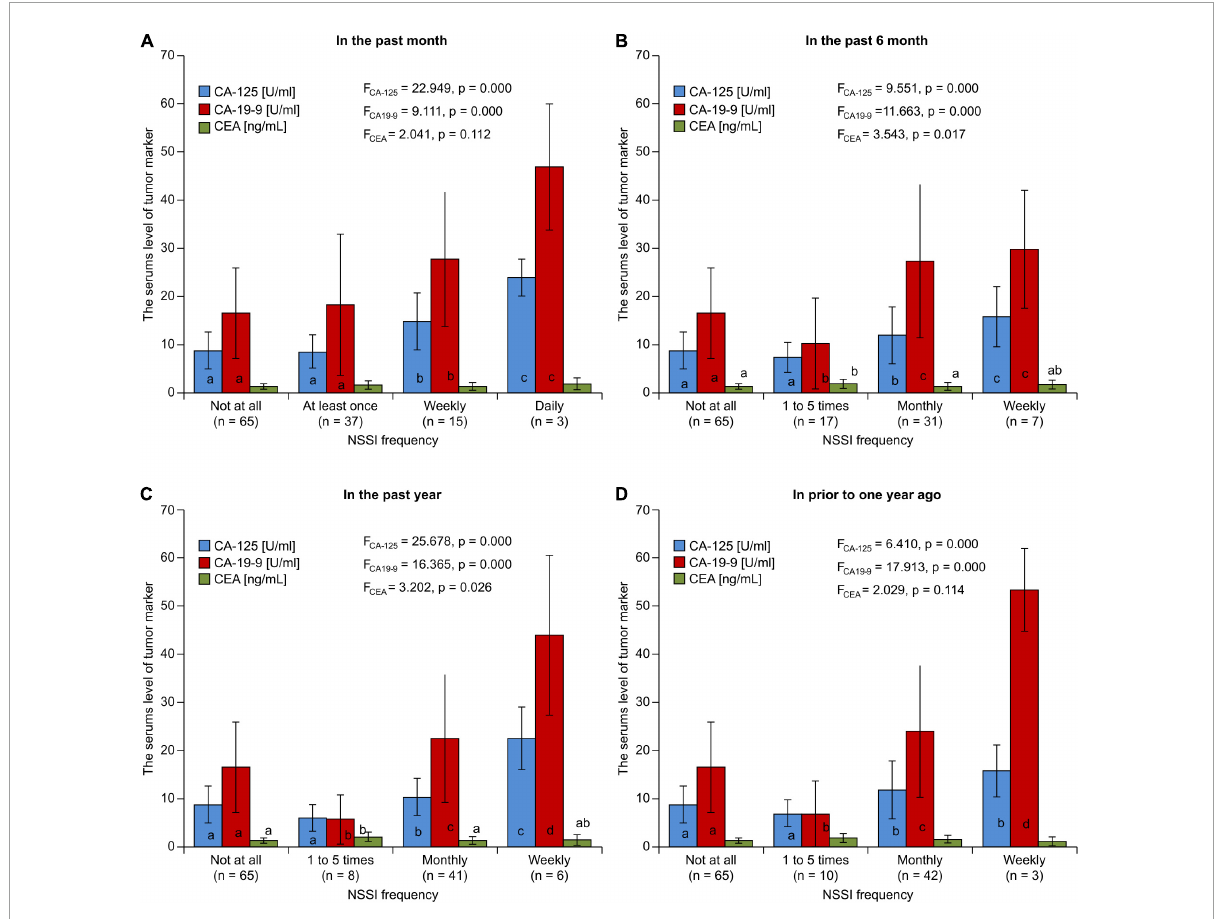
FIGURE3 The comparison of serum level of tumor marker grouped according to NSSI frequency in the past (A) month (B) 6 months (C) year (D) prior to one